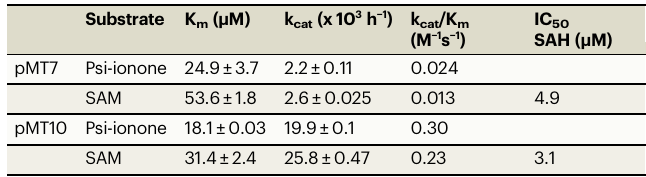
Table 1 | Kinetics parameters of pMT7 and pMT10 Substrate K m